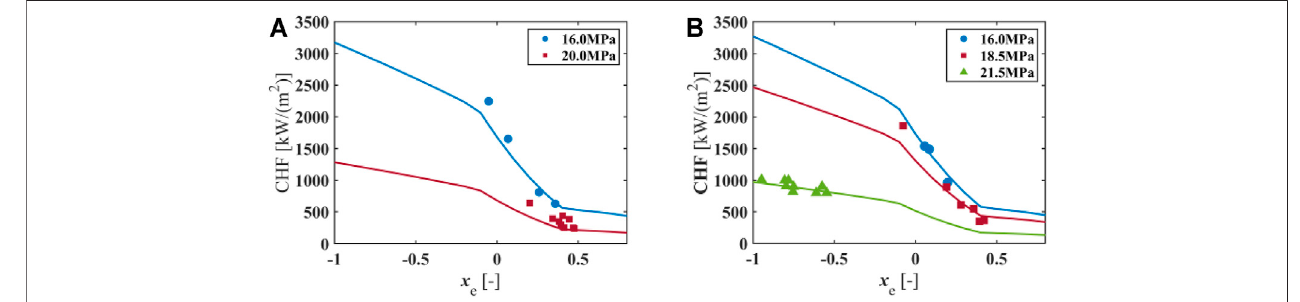
FIGURE 7 | Variation in CHF with quality at different pressures for water. (A) G (cid:1) 1,000 kg/(m 2 · s), D (cid:1) 10 mm. (B) G (cid:1) 1,500 kg/(m 2 · s), D (cid:1) 10 mm.